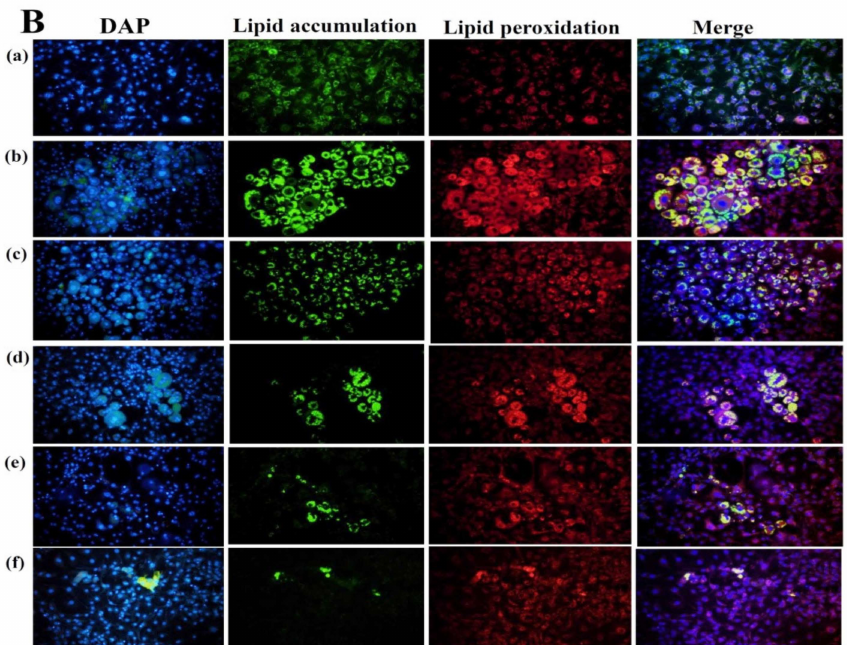
Figure 2. E ff ect of spilanthol (SP) lipid accumulation and droplets in 3T3-L1 cells. ( A ) 3T3-L1 pre-adipocytes were di ff erentiated in medium containing various concentrations of SP and the di ff erentiated adipocytes examined on day 8 by Oil Red staining: (a) 3T3-L1 pre-adipocytes; (b) 3T3-L1 adipocytes; (c) 3T3-L1 adipocytes + 3 µ M SP; (d) 3T3-L1 adipocytes + 10 µ M SP; (e) 3T3-L1 adipocytes + 30 µ M SP; (f) 3T3-L1 adipocytes + 100 µ M SP. ( B ) Intracellular triglyceride accumulation and lipid peroxidation measured using 4 (cid:48) ,6-diamidino-2-phenylindole (DAPI)